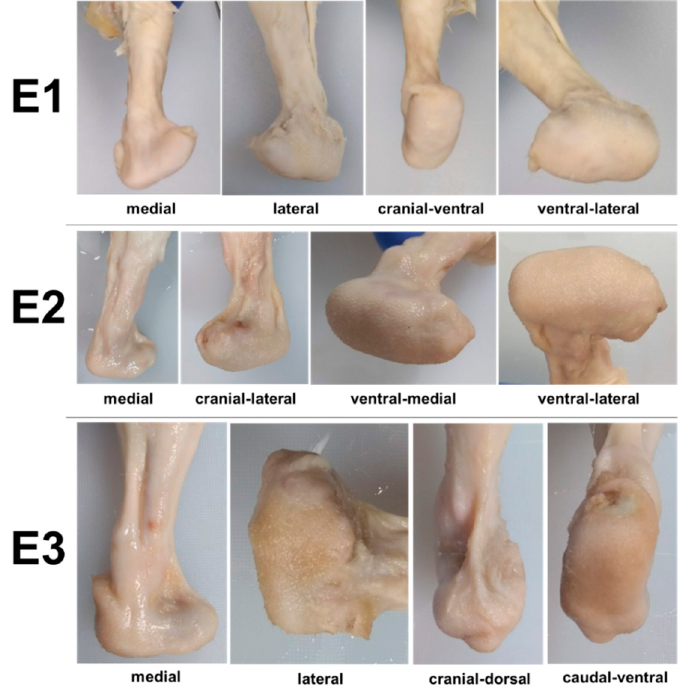
Figure 4. Photographs of the formalin-fixed skin with fur removed from rabbits E1–E3. The skin surrounding the endoprostheses appeared normal.